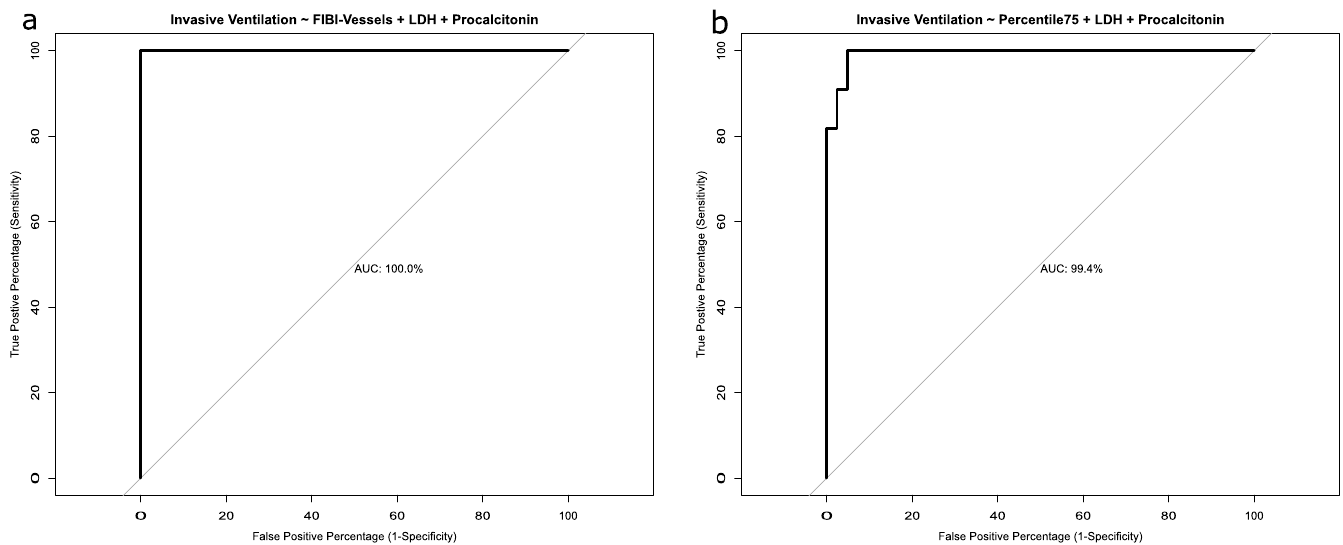
Fig 6. ROC curves for invasive ventilation consisting of the combination of QCT and laboratory work: FIBI -700 , LDH and Procalcitonin; (b) 75 th percentile lung density, LDH and Procalcitonin.